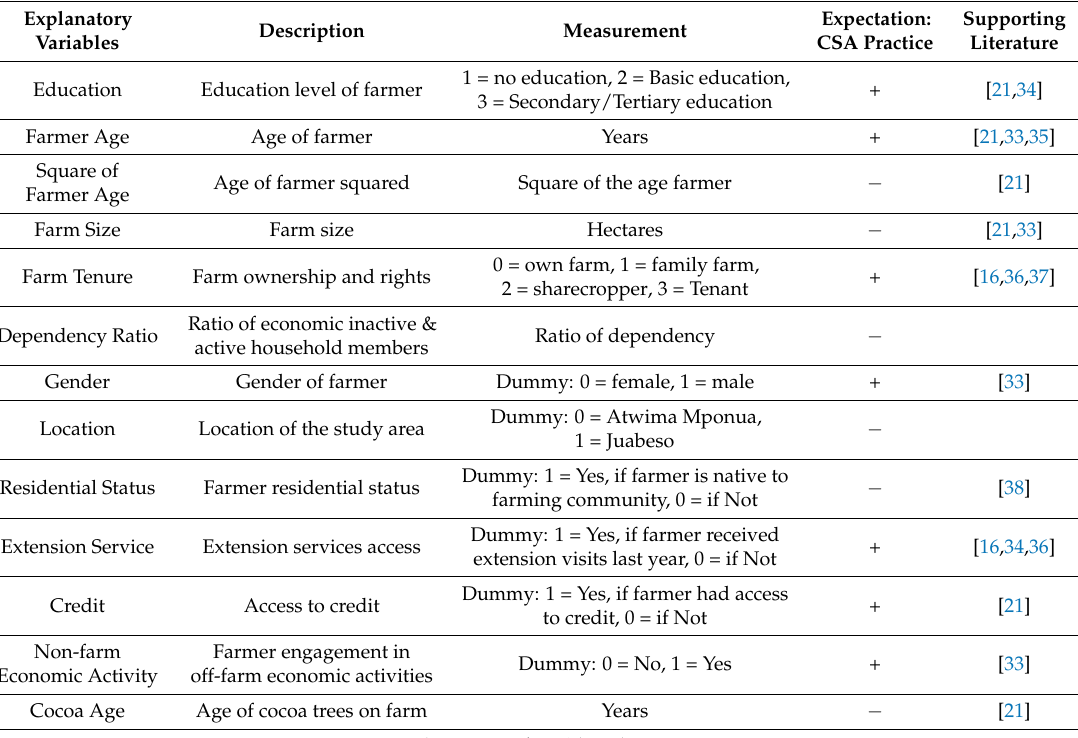
Table 3. A Priori Expectations for Explanatory